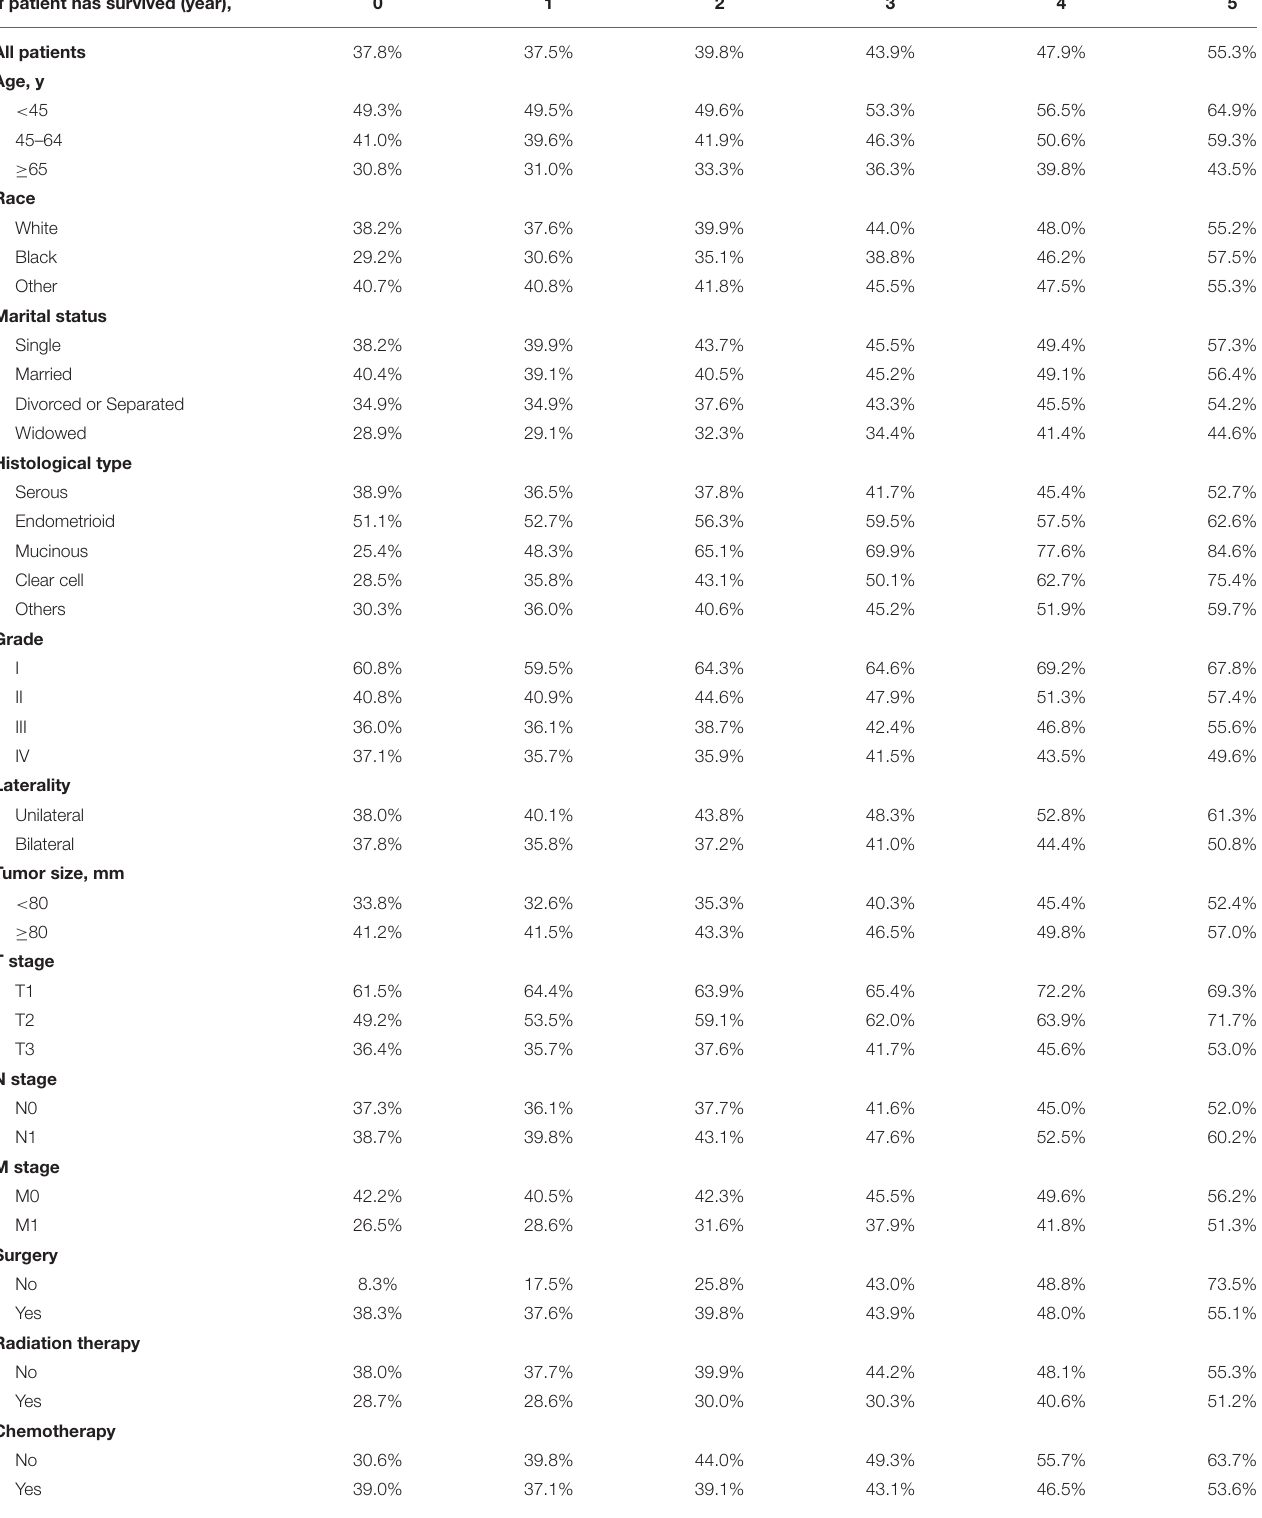
TABLE 5 | CS5 of patients in different subgroups of clinicopathologic characteristics. If patient has survived